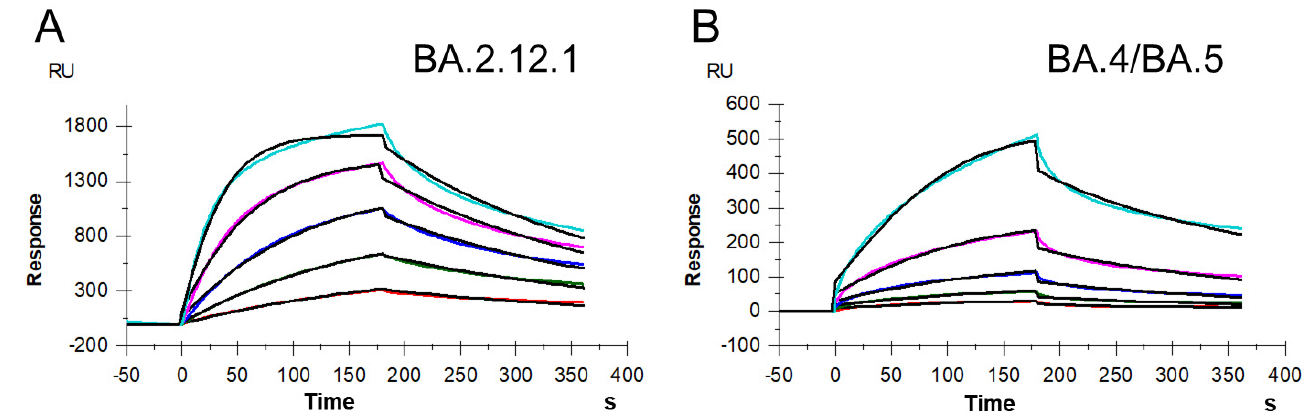
Figure 2. SPR sensorgrams of S protein RBD of BA.2.12.1 and BA.4/BA.5 binding with heparin. ( A ) SPR sensorgrams of S protein RBD of BA.2.12.1 binding with heparin. Concentrations of RBD (from top to bottom) are 1000, 500, 250, 125, and 63 nM, respectively. ( B ) SPR sensorgrams of S protein RBD of BA.4/BA.5 binding with heparin. Concentrations of RBD (from top to bottom) are 1000, 500, 250, 125, and 63 nM, respectively. Table 1. Summary of kinetic data of S protein RBD of BA.2.12.1 and BA.4/BA.5 binding with heparin.